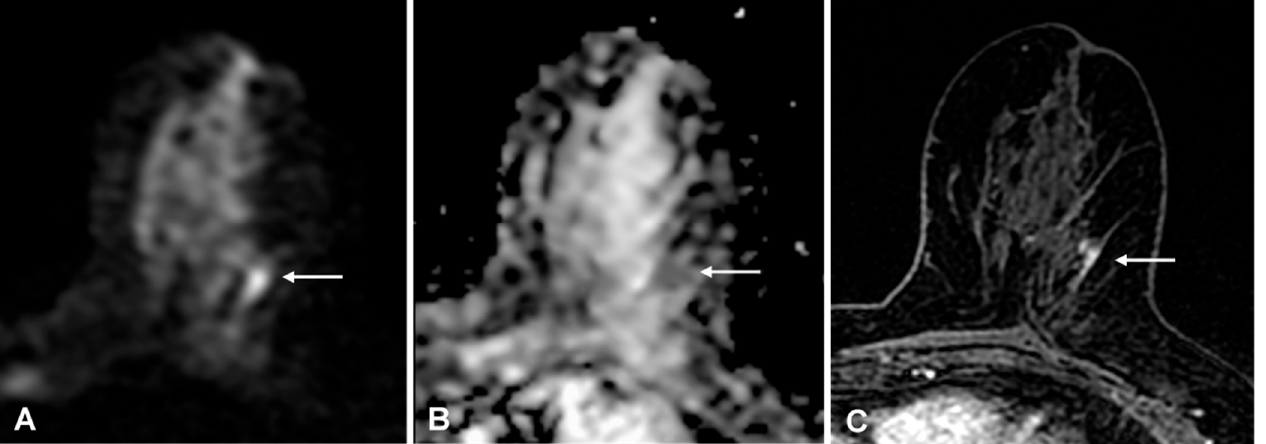
Figure 4. ( A ) 54-year-old woman with a 15-mm invasive ductal carcinoma: true-positive finding on diffusion-weighted imaging (DWI) that was detected by expert readers only. A, DWI (b = 1000 s/mm2) shows a mild linear hyperintense lesion in the upper outer portion of the left breast (arrow). ( B ) apparent diffusion coefficient-map shows corresponding homogeneous hypo-intensity. ( C ) for comparison, the axial T1-weighted fat-sat contrast-enhanced image shows focal non-mass enhancement in the same location (arrow).